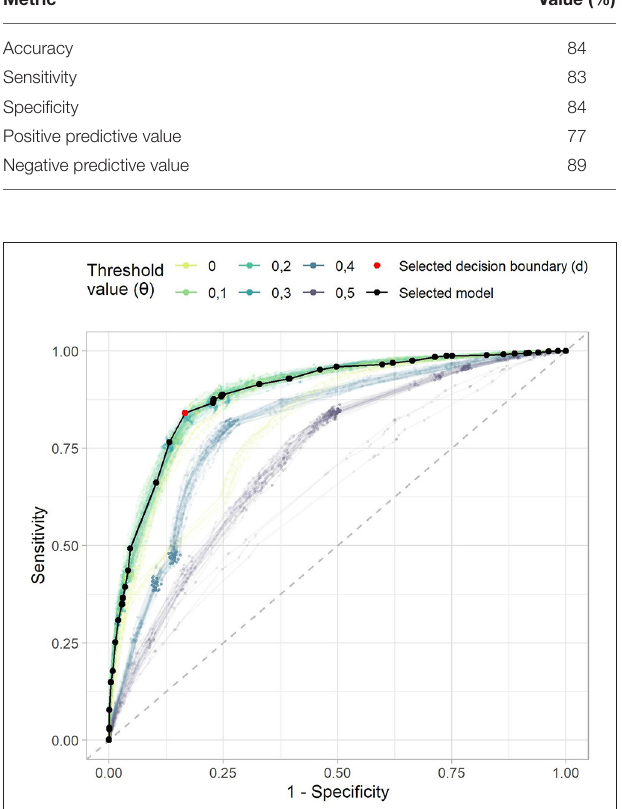
FIGURE 2 | The receiver operating characteristic of the example rule sets. The dashed gray line denotes a random predictor. The model that we selected for further analysis is shown in black, the selected decision boundary d in red. Each point denotes one possible decision boundary, while the x-axis denotes one minus the specificity, and the y-axis the sensitivity of the model given this decision boundary. The color lines indicate the curves of all other models with the maximum aggregation function.